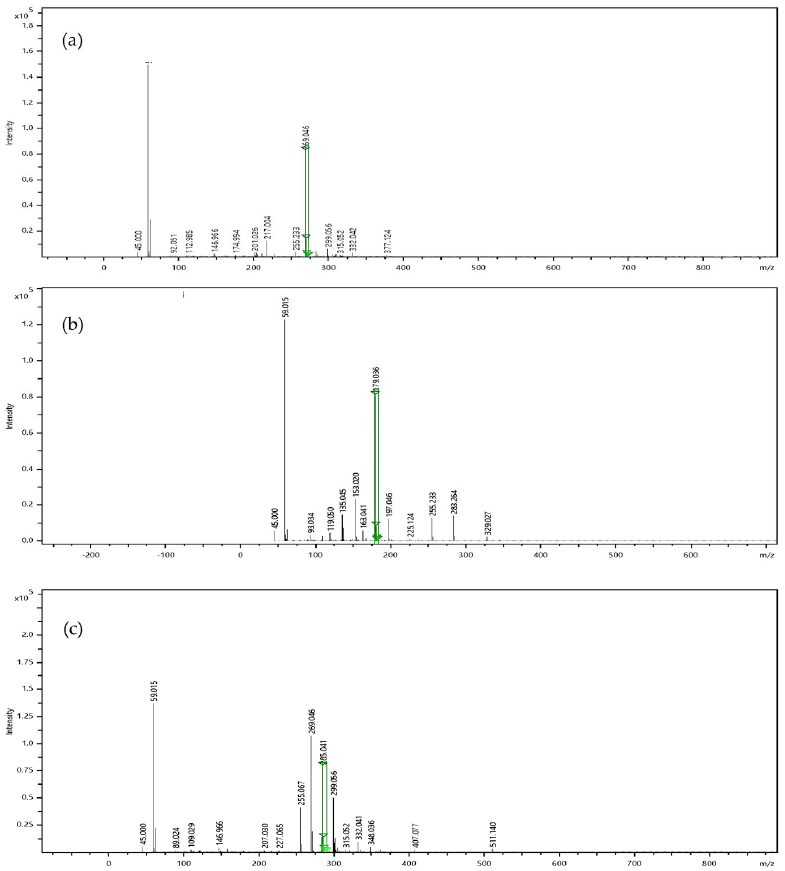
Figure 3. Mass spectrum of parsley extract samples at negative ionization were the precursor ion of apigenin— m / z 269 ( a ), caffeic acid— m / z 185 ( b ), and luteolin— m / z 285 ( c ) are obtained.